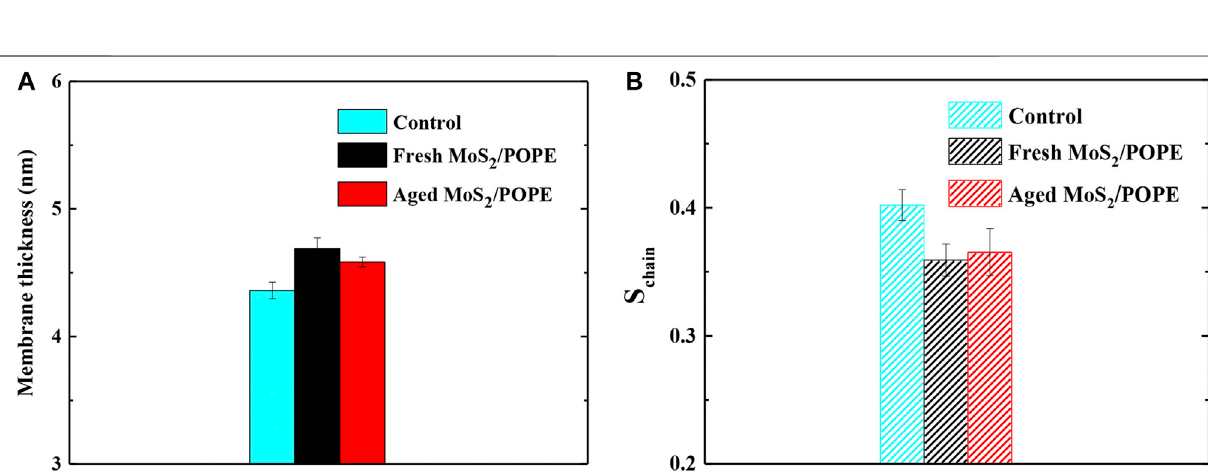
Frontiers in Chemistry |